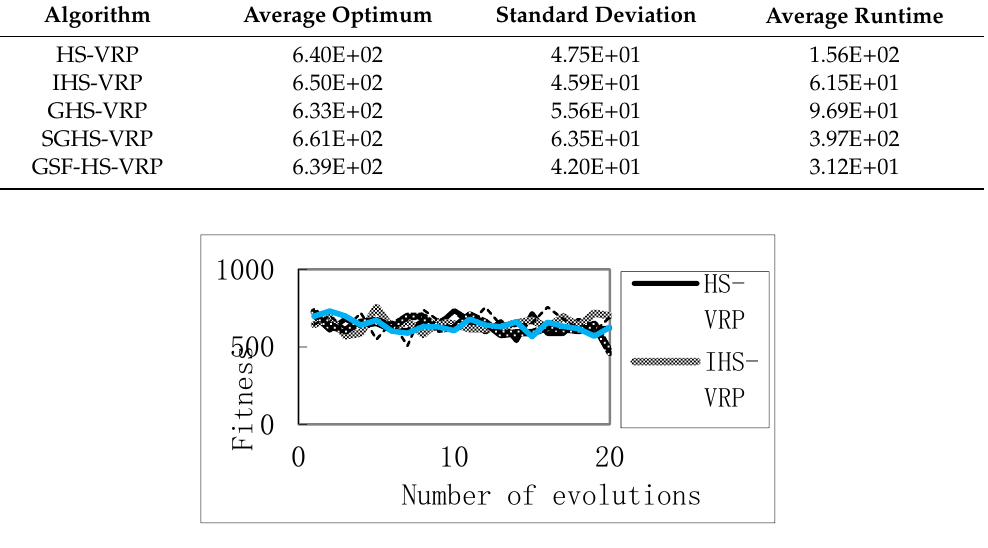
Figure 3. Average optimum iteration curve of each algorithm. Table 5. Comparison results of vehicle routing optimization of each algorithm.